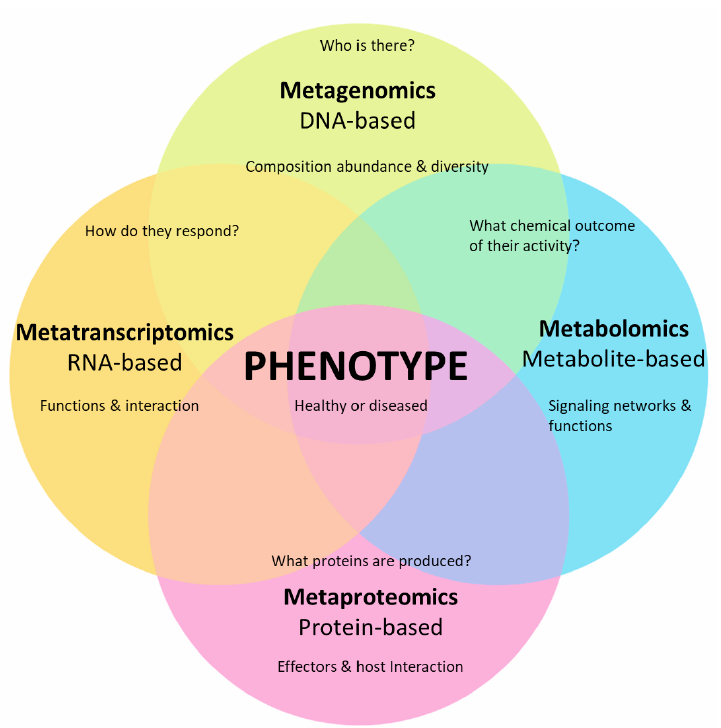
Figure 2. Advances in various aspects of meta-omics (i.e., meta-genomics, meta-transcriptomics, and meta-proteomics) in combination with metabolomics have substantially improved our understanding of plant-associated microbial communities and their influence on the phenotype (healthy plant growth or disease development).